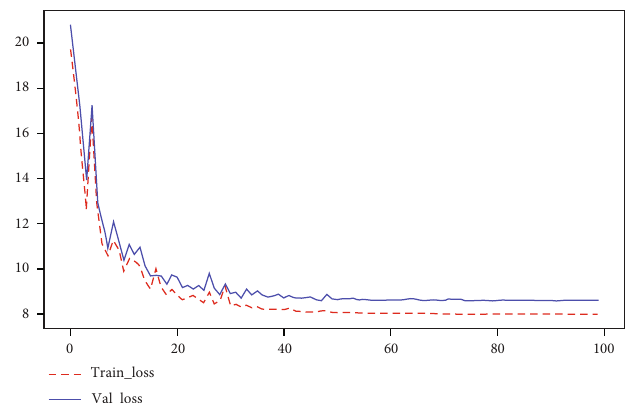
Figure 8: The change of MAE of metro tra ffi c fl ow prediction model based on knowledge graph representation learning.